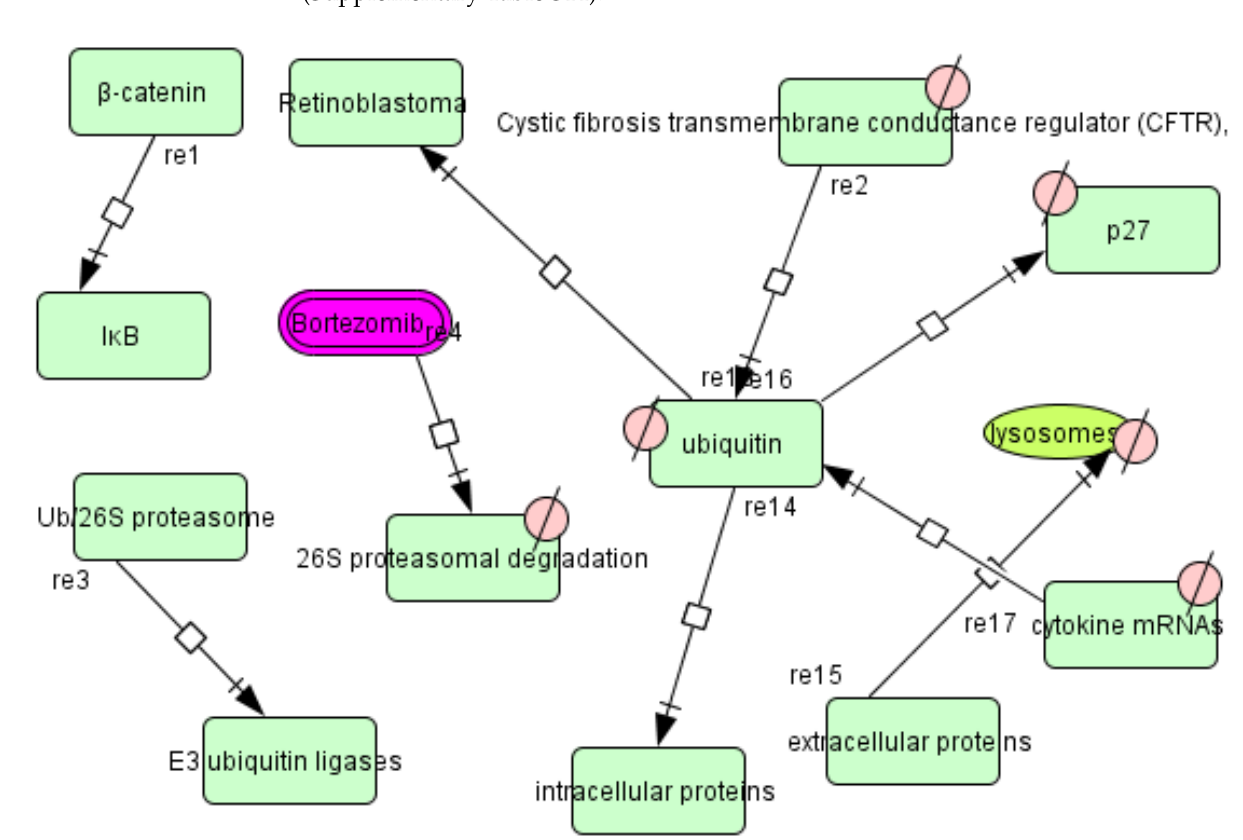
Figure 3. The network of the ubiquitin-proteasome pathway developed using the CellDesigner software (version — 4.4.2).